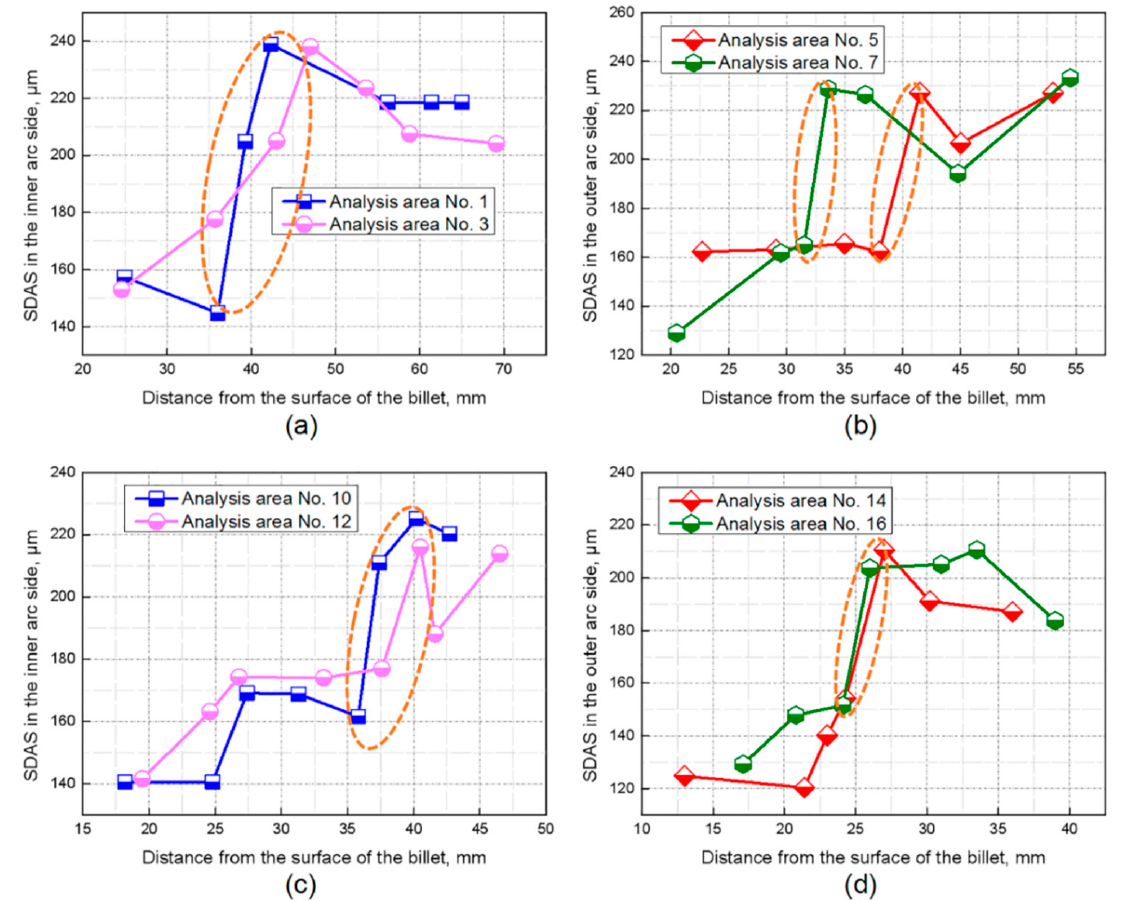
Figure 3. Partial SDAS measurement results from the surface to center. For billet No. 1, the SDAS at analysis areas No. 1and 3 on the inner arc side and the SDAS at analysis areas No. 5 and 7 on the outer arc side are shown in ( a , b ), respectively. For billet No. 2, the SDAS at analysis areas No. 10and 12 on the inner arc side and the SDAS at analysis areas No. 14 and 16 on the outer arc side are shown in ( c , d ), respectively. The uneven selection of measurement results can explain the consistency of